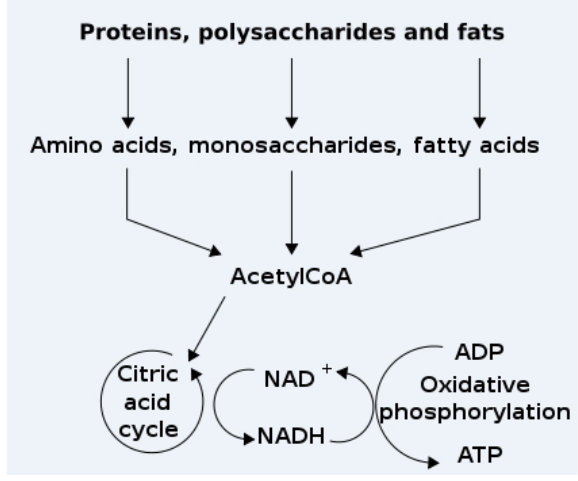
Figure 1: Production and Utilization of Acetyl CoA: The complex macromolecules present in dietary food are processed through various metabolic pathways into Acetyl CoA. Acetyl CoA in the mitochondria is then oxidized to carbon dioxide and water through the Citric Acid Cycle and Oxidative Phosphorylation. The electrochemical energy generated due to the transfer of electrons from NADH or FADH to O in a series of electron transfer reaction is 2 2 utilized to synthesize